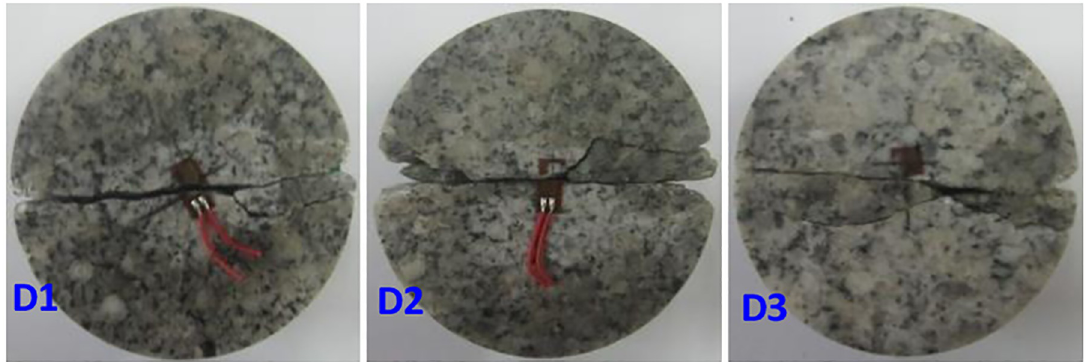
Fig 11. Failure model of the Brazil disk split test.